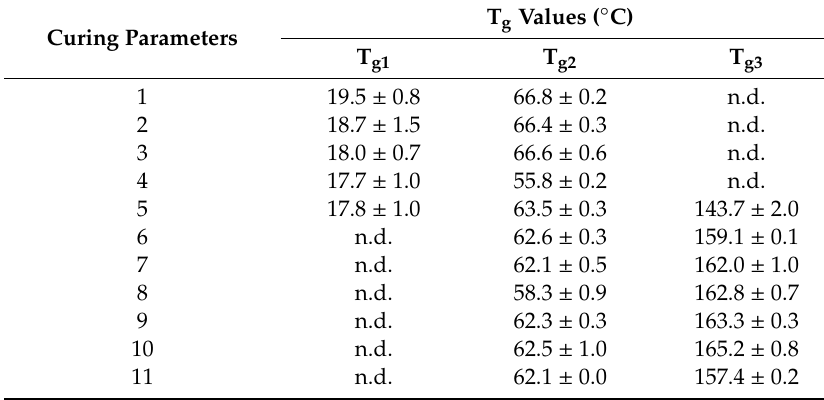
Table 2. Average and standard deviation values of T g calculated from di ff erential scanning calorimetry